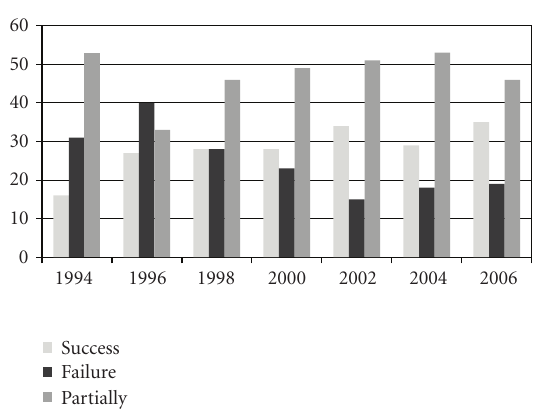
Figure 1: Statistics of successfulness of the developing the